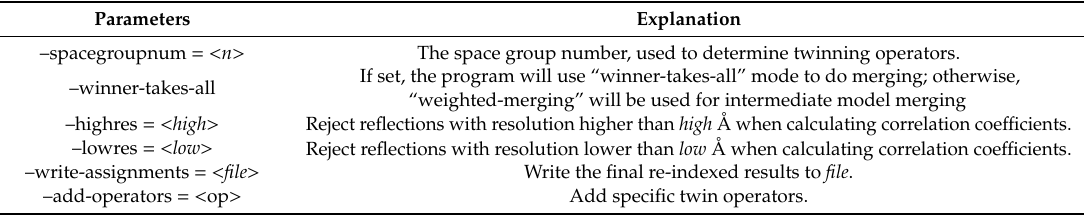
Table 1. New input parameters for the EM-detwin